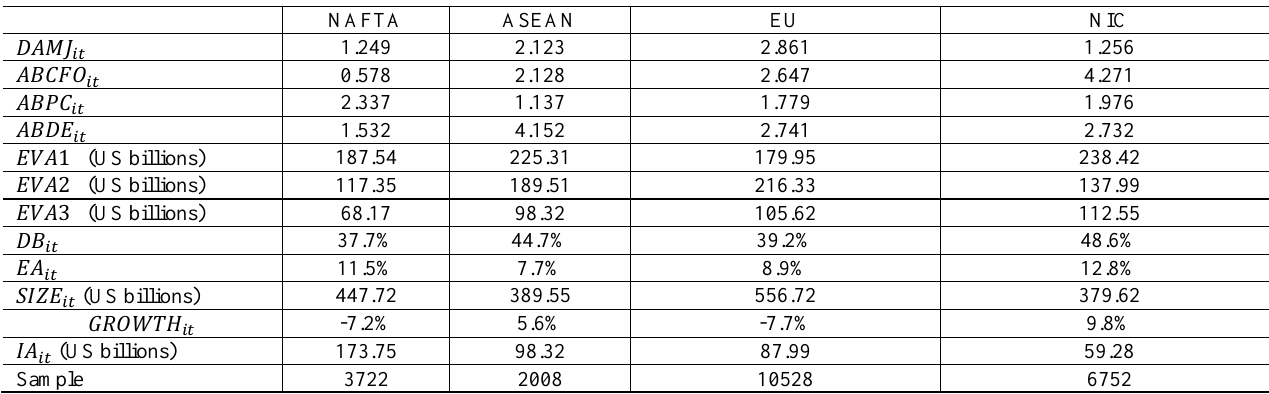
Table 1: Descriptive statistics (all samples)